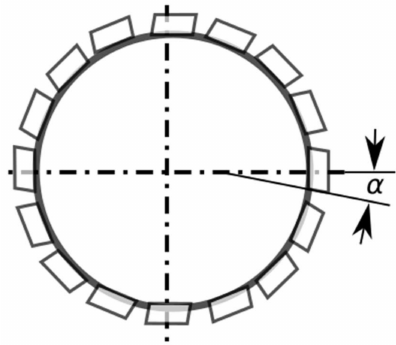
Figure 14. The scavenging port angle against the normal direction.